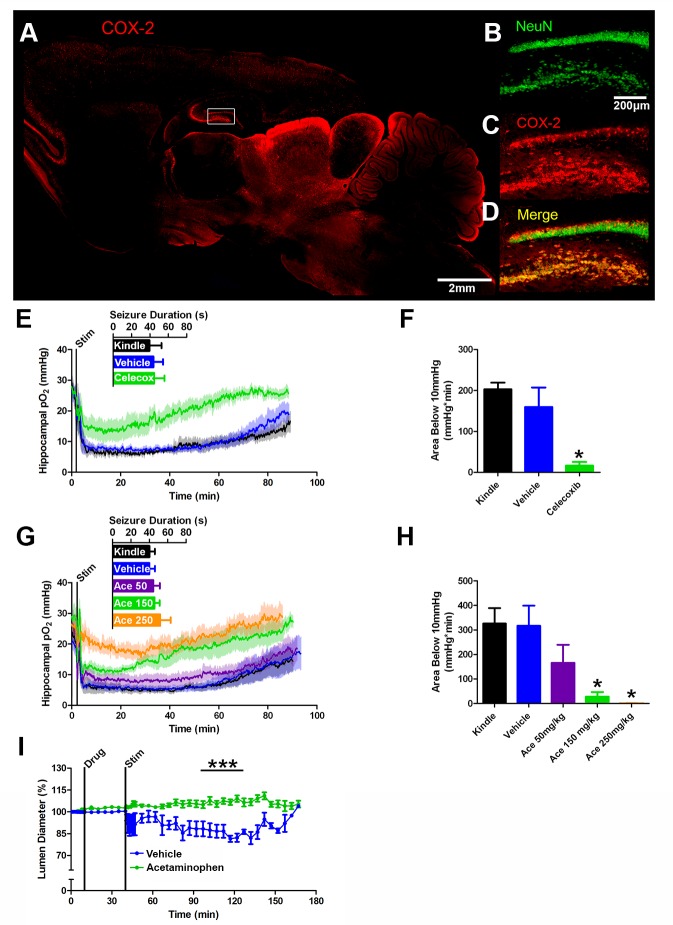
COX-2 activity during a seizure is required for postictal severe hypoxia.(A) COX-2 expression in sagittal section. Hippocampal inset is displayed (see B–D). Scale bar = 2 mm. (B–D) Contents of inset from (A). Many NeuN-expressing neurons (B) in DG and hilus express COX-2 (C). (D) displays colocalization of NeuN and COX-2. Scale bar = 200 µm. (E) Celecoxib pre-treatment (20 mg/kg) inhibited severe hypoxia during the postictal period (n = 5). Inset reveals no difference in seizure duration. (F) Celecoxib caused a significant reduction in the area below 10mmHg. *p<0.05 (within subject ANOVA). (G) Acetaminophen (Ace) dose-dependently inhibited postictal severe hypoxia (n = 5). Doses are listed on inset (50–250 mg/kg). Inset reveals no difference in seizure duration. (H) 150 mg/kg and 250 mg/kg of acetaminophen significantly decreased the area below 10mmHg. *p<0.05 (within subject ANOVA). (I) Lumen diameter over time following application of acetaminophen (100 µM; n = 7 or vehicle (n = 5). Acetaminophen treatment prevented post-stimulation constriction (analyzed between 60–90 min post-stim). ***p<0.001.